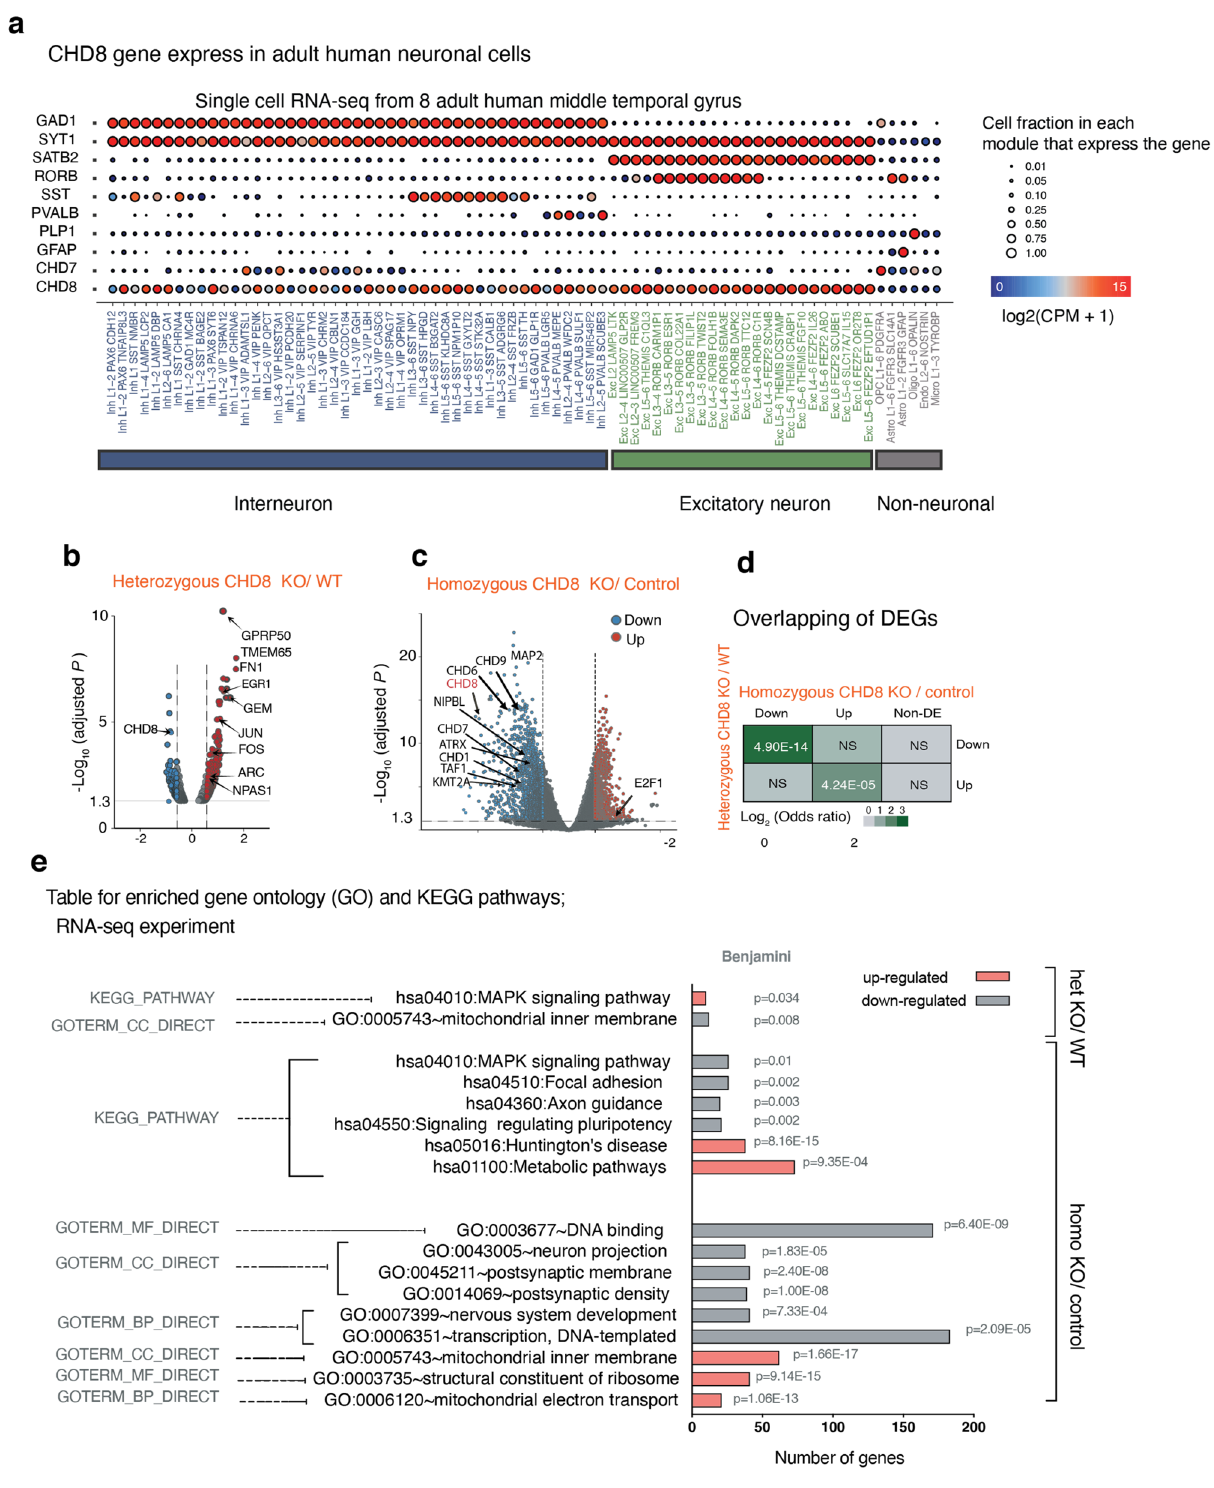
Figure 4. Loss of CHD8 leads to prominent gene downregulation in human excitatory neurons. ( a ) Single-cell RNA sequencing data showing expression of CHD8 and cell-type-specific marker genes (CPM + 1) in human cortical neurons (image credit: Allen Institute) 37 . ( b ) Volcano plot for RNA-seq fold change in heterozygous CHD8 KO versus control neurons. ( c ) Volcano plot for RNA-seq fold change in homozygous CHD8 KO versus control neurons. ( d ) Analysis for overlapping DEGs between the heterozygous and homozygous knockout RNA-seq experiment shows that the odds ratio of downregulated genes is significantly higher compared to overlapping upregulated genes. ( e ) Results of gene ontology (GO) and KEGG pathway analysis for up and downregulated genes in heterozygous CHD8 KO to WT and homozygous CHD8 KO to control